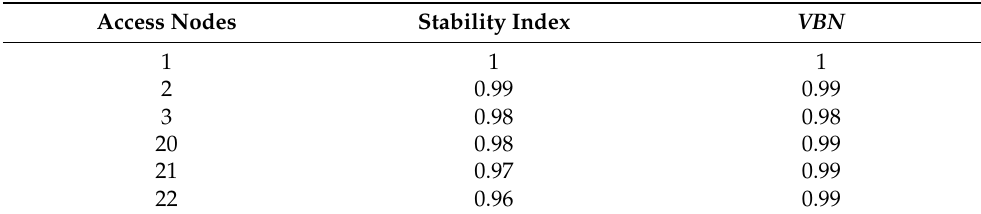
Figure 7. Effect of different access points on active power network loss. After considering both the stability index curve and the active network loss curve, the energy storage device is connected to the above nodes, the tidal current calculation is carried out, and finally node 6 and node 30 are selected. Due to the three branches of the